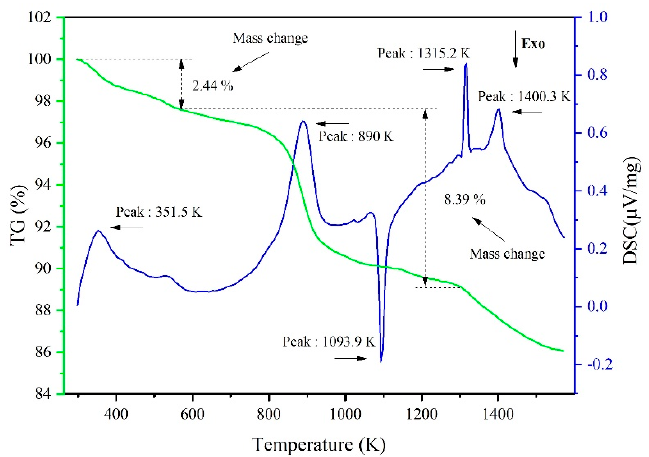
Figure 12. TG and DSC curves of the raw materials in presence of CaF 2 .